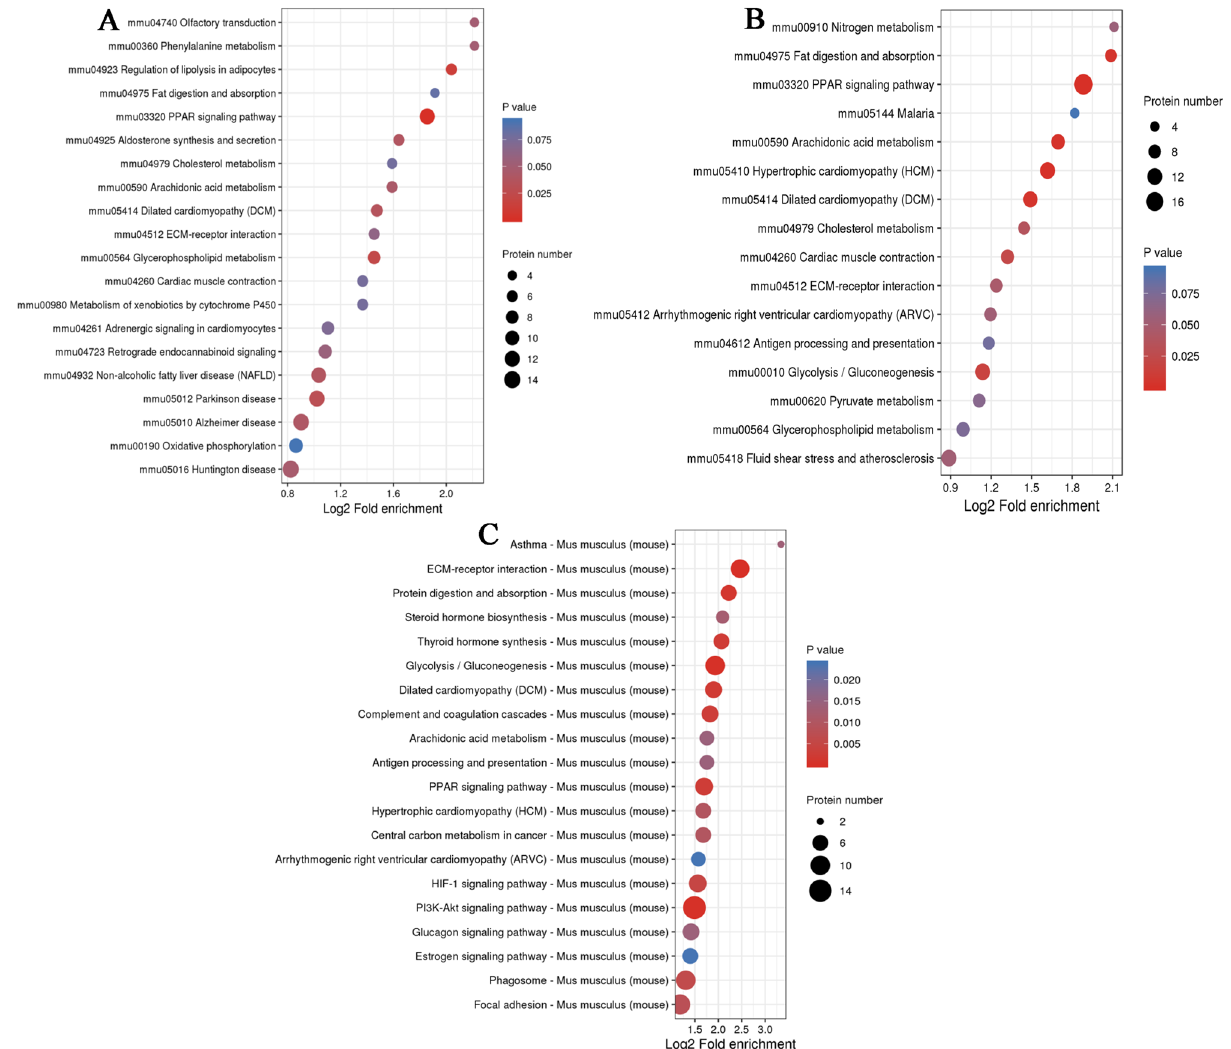
Figure 5. Enriched bubble charts of Kyoto Encyclopedia of Genes and Genomes pathway analysis of differentially expressed proteins in the (A) WF/WC, (B) WS/WF and (C) WS/WC